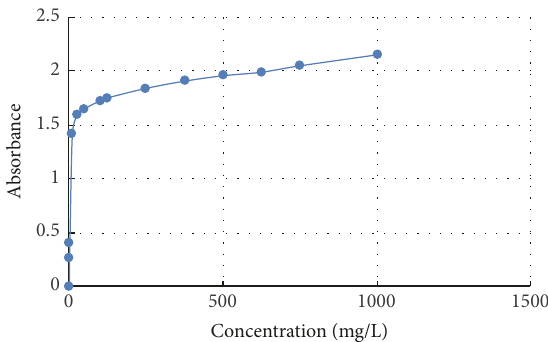
Figure 1: Absorbance versus concentration of the methylene blue dye.